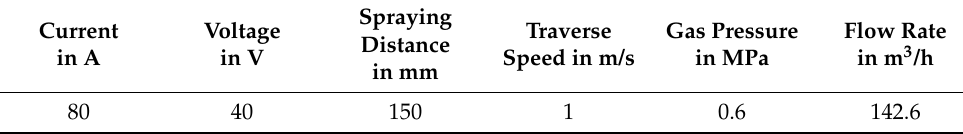
Table 4. Thermal spraying